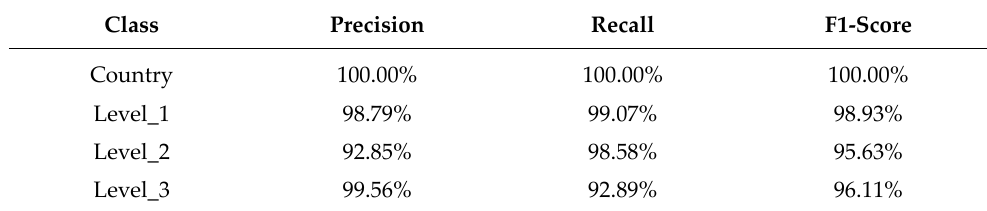
Table 4. Precision, Recall, and